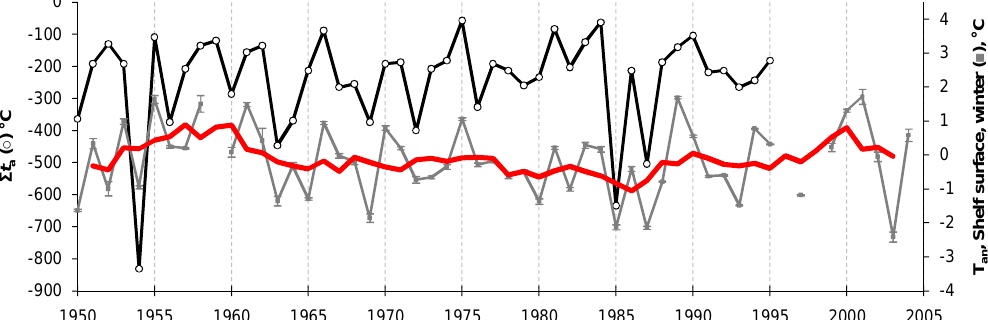
Fig. 9. Long-term time series of the winter severity index 6t a ( ◦ C) for the North-Western part of the Black Sea (black line + circles, redrawn from Belokopytov, 1998) and time series of the winter (December–April) temperature anomaly ( ◦ C) of the shelf surface (grey line + squares), and the 5-yr running mean (red line). Error bars show the standard error of the mean.